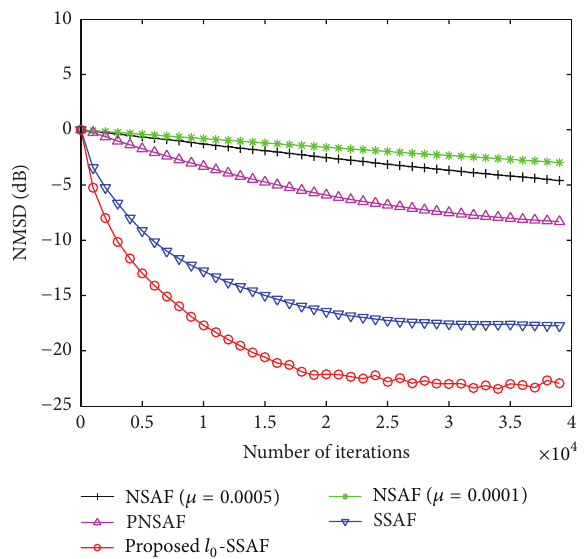
Figure 9: NMSD learning curves of the NSAF, PNSAF, SSAF, and 𝑁 = 4 ,SIR = −10 𝑙 0 -SSAFalgorithms[